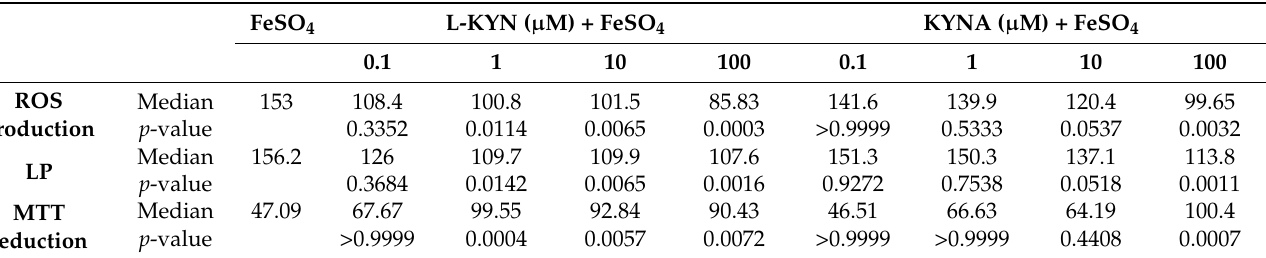
Figure 5. Effect of kynurenines on ROS production induced by FeSO 4 . Brain homogenates were incubated with L-KYN and KYNA (0–100 µM) with or without FeSO 4 (10 µM). Data represent the mean ± S.E.M. of at least 5 independent experiments per concentration. * p < 0.05 FeSO 4 vs. control; # p < 0.05 L-KYN with a specific concentration vs. FeSO 4 ; and & p < 0.05 KYNA with a specific concentration vs. FeSO 4, based on the Kruskal–Wallis test with Dunn’s test for multiple pairwise comparisons. Table 3. Effect of L-KYN and KYNA on ROS production, LP and MTT reduction induced by FeSO 4 . Medians of ROS production, PL and MTT reduction percentages and p -values associated with the effect of L-KYN and KYNA for each concentration vs. FeSO 4 , according to Dunn’s test for multiple pairwise comparisons.